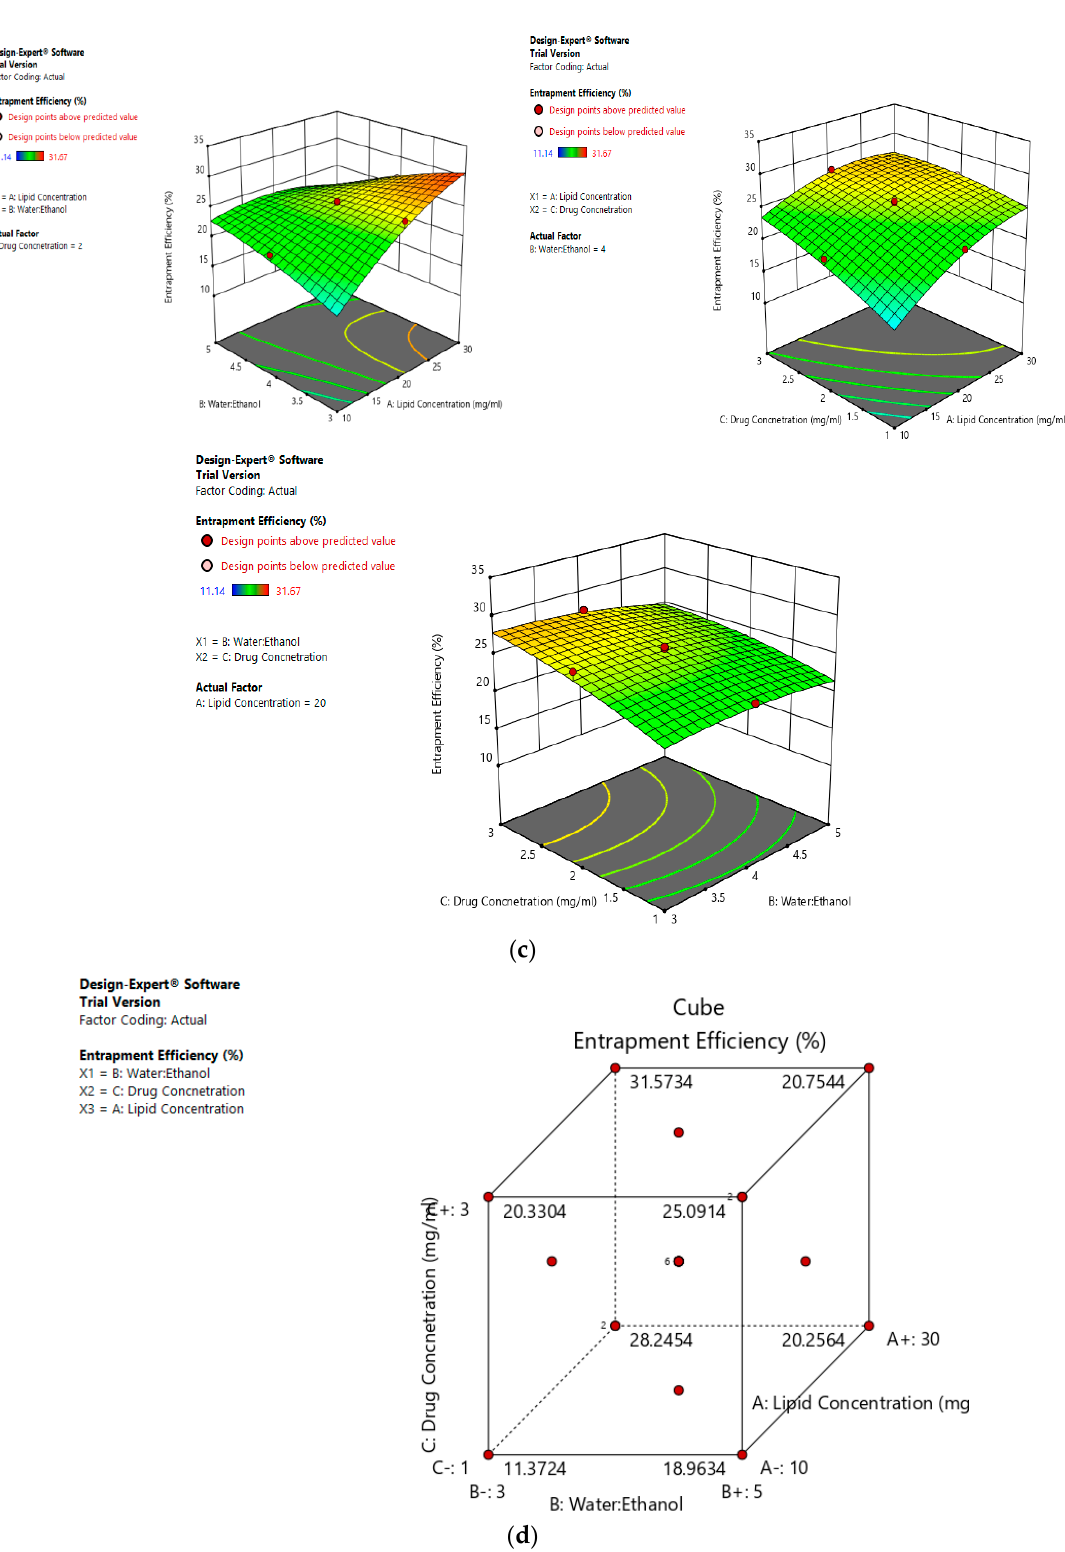
Figure 3. Effect of factors on entrapment efficiency of DL ( a ) Effect of individual factors on Figure 3. E ff ect of factors on entrapment e ffi ciency of DL ( a ) E ff ect of individual factors on Entrapment Entrapment Efficiency; ( b ) Effect of combinations of two factors on Entrapment Efficiency (2D plots); E ffi ciency; ( b ) E ff ect of combinations of two factors on Entrapment E ffi ciency (2D plots); ( c ) E ff ect ( c ) Effect of combinations of two factors on Entrapment Efficiency (3D plots); ( d ) Effect of all three of combinations of two factors on Entrapment E ffi ciency (3D plots); ( d ) E ff ect of all three factors on factors on Entrapment Efficiency. Entrapment E ffi